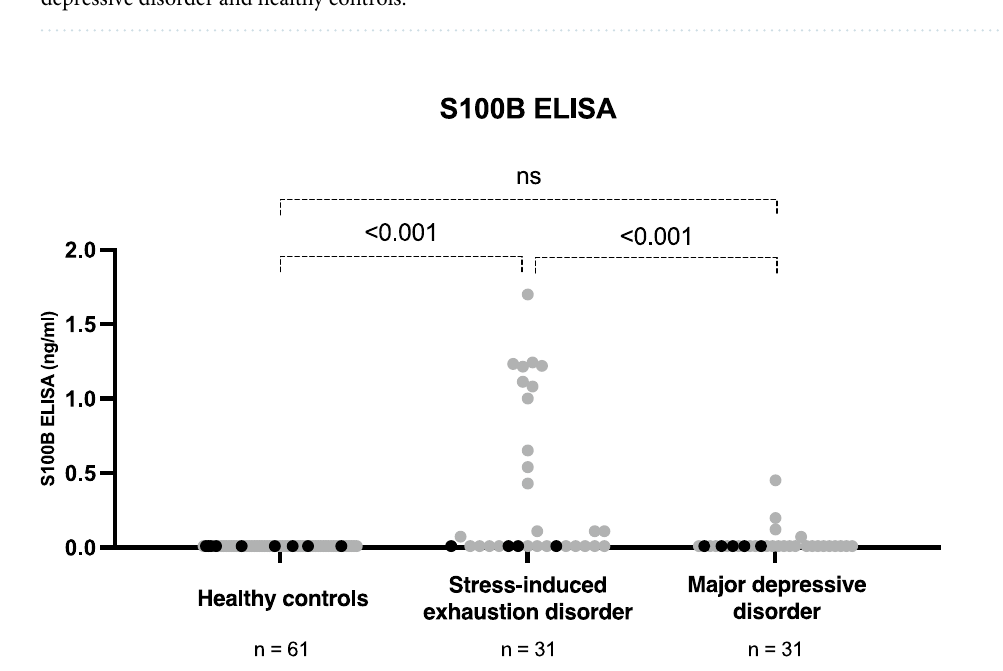
Figure 1. Plasma levels of S100B measured by enzyme-linked immunosorbent assay (ELISA). Gray dots represent women and black dots represent